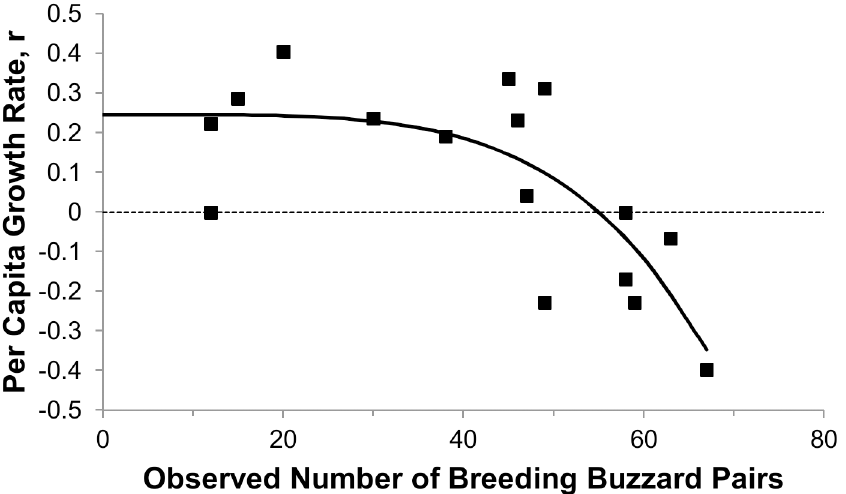
Fig 2. Relationship between per capita growth rate, r, and number of common buzzard breeding pairs in Finland study area [42]. r = ln λ , where λ is the annual population growth factor. This relationship is represented by the theta-logistic equation re-written to calculate the population growth rate as r = r max (1 – (N/ K) θ ), where N = population size, K = carrying capacity of 1750, r max = r at N = 0. The θ of the curve is 4.45. This high θ indicates r does not decrease much until density is close to K, the steady-state population size (i.e., where the curve crosses the r = 0